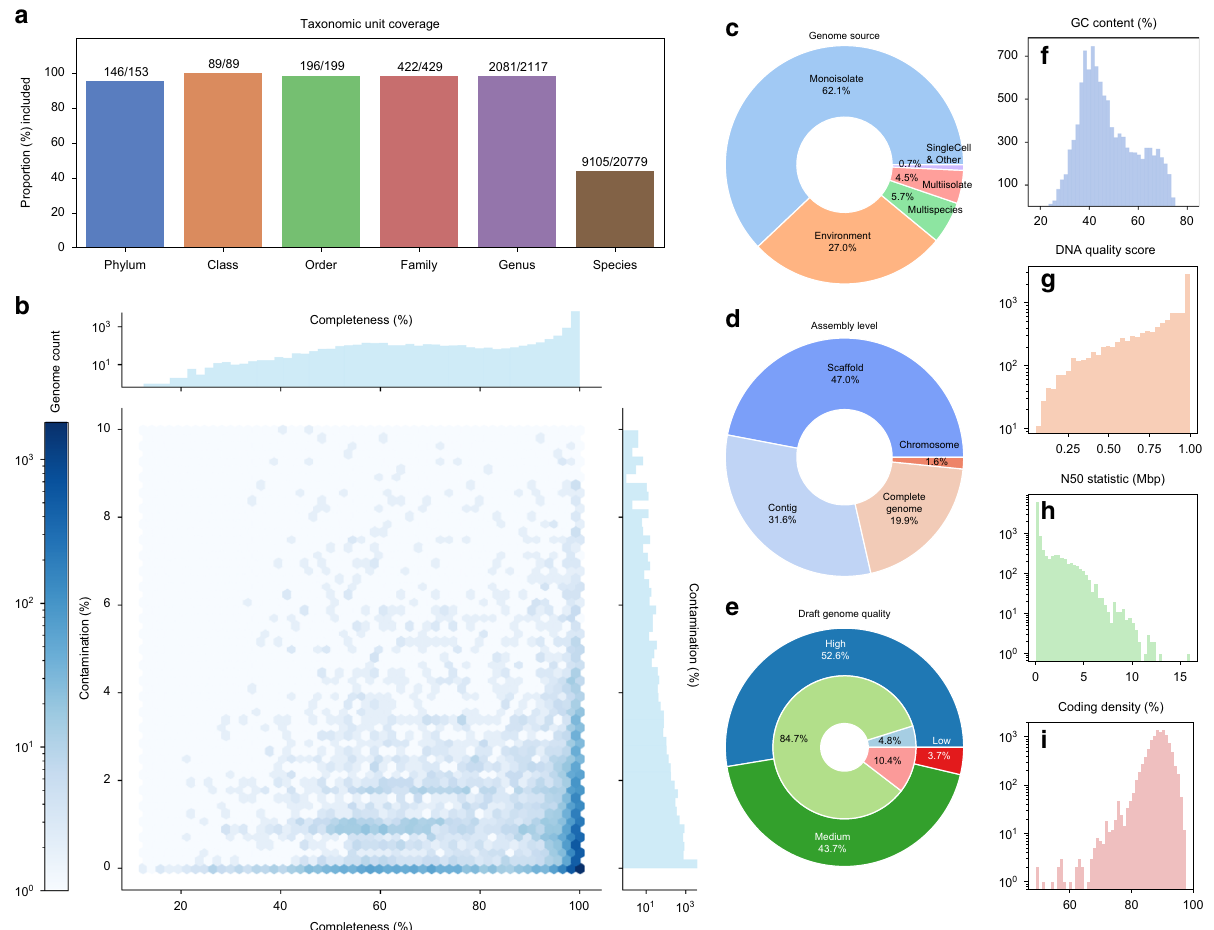
Fig. 2 Statistics of the 10,575 bacterial and archaeal genomes selected for phylogenetic reconstruction. a Numbers and proportions of NCBI-de fi ned taxonomic units included from all 86,200 available genomes. b Distribution of completeness vs. contamination scores computed by CheckM 44 . c Distribution of genome sources, i.e., the “ scope ” property de fi ned by NCBI. d Distribution of genome assembly levels. e Distribution of draft genome quality, determined following the standard established by Bowers et al. 6 . Speci fi cally: “ high ” : completeness > 90%, contamination < 5%, presence of 23S, 16S, 5S rRNAs, and ≥ 18 tRNAs; “ medium ” : completeness ≥ 50%, contamination < 10%; “ low ” : completeness < 50%, contamination < 10%. The outer, darker circle represents all genomes. The inner, lighter circle represents genomes assembled from metagenomes (MAGs). f Distribution of GC contents. g Distribution of DNA quality scores, calculated following Land et al. 41 . h Distribution of N50 statistics of nucleotide sequences per genome. i Distribution of coding density. The y -axes in f – h represent genome counts. Source data are provided as a Source Data fi